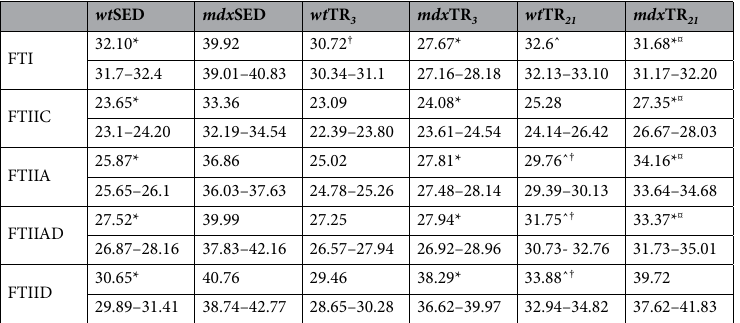
Table 1. Mean of minimal Feret’s diameter (μm) and the respective 95% confidence intervals in soleus fibers type I, type IIC, type IIA, type IIAD and type D fibers in the different groups studied. *p < 0.05 compared to mdx SED; † p < 0.05 compared to wt SED; ¤ p < 0.05 compared to mdx TR 3 ; ˆcompared to wt TR 3 .